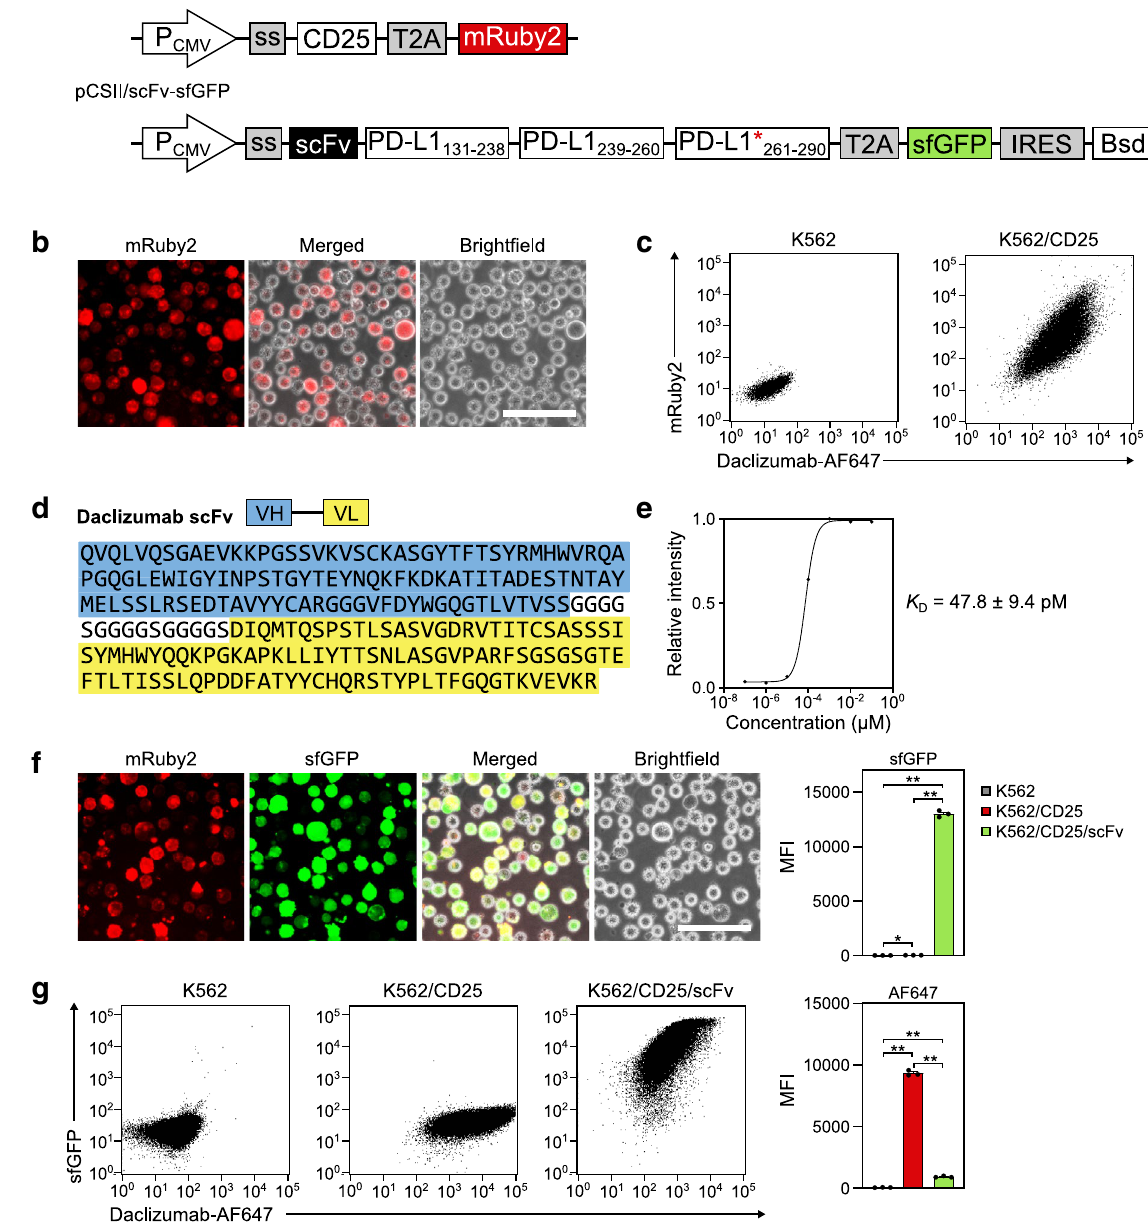
Figure 3. Validation of the MAGPIE system using the daclizumab scFv. ( a ) Diagram of the cDNA constructs. The red asterisk indicates that the PD-L1 sequence contained the T290M mutation. ( b ) mRuby2 expression in the K562/CD25 cell line established by lentiviral transduction with the pCSII/CD25-mRuby2 vector. Scale bar = 100 µm. ( c ) Expression of CD25 on K562/CD25 cells. Coexpression of CD25 on the cell surface with cytosolic expression of mRuby2 was detected by flow cytometry after incubation with daclizumab-AF647. Wildtype K562 cells were used as a control. ( d ) Structural diagram and sequence of the daclizumab scFv. VH and VL sequences are highlighted by blue and yellow, respectively. The linker sequence is also shown. ( e ) Estimation of daclizumab scFv binding to CD25 by an ELISA. The K D value was estimated by curve fitting with non-linear regression and is shown with the standard error. ( f ) (left) mRuby2 and sfGFP expression in K562/CD25/scFv cells produced by lentiviral transduction with the pCSII/scFv-sfGFP vector. Scale bar = 100 µm. (right) Mean fluorescence intensity values of sfGFP calculated using flow cytometry plots from three independent experiments. * P < 0.005; ** P < 0.0001. ( g ) (left) Inhibition of daclizumab-AF647 binding by surface expression of daclizumab scFv. K562/CD25/scFv cells that expressed both CD25 and daclizumab scFv were incubated with daclizumab-AF647 prior to flow cytometric analysis. Wildtype K562 and K562/CD25 cells were used as controls. Representative scatter plots from three independent experiments are shown. (Right) Mean fluorescence intensity values of AF647 calculated using flow cytometry plots from three independent experiments. ** P <